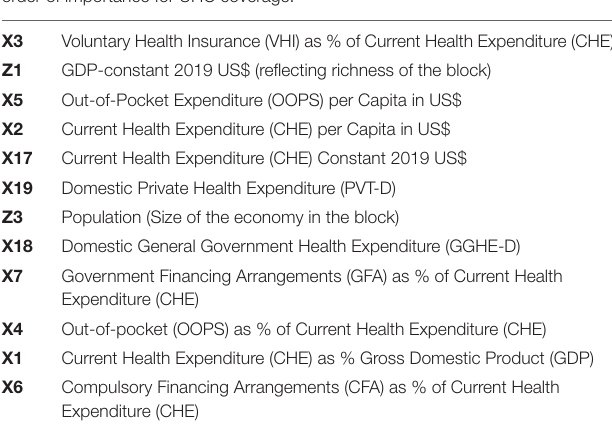
TABLE 5 | Developed AUKUS economic block had the predictors in decreasing order of importance for UHC